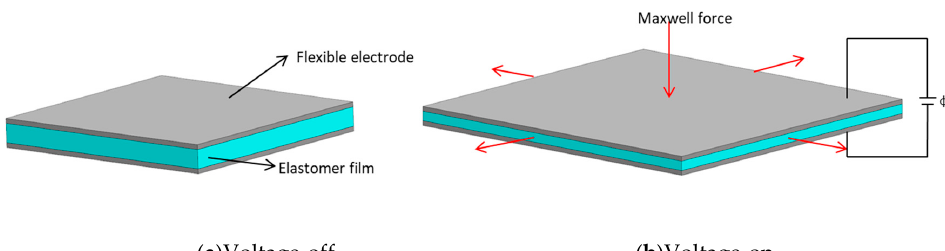
Figure 2. The working principle of DE.